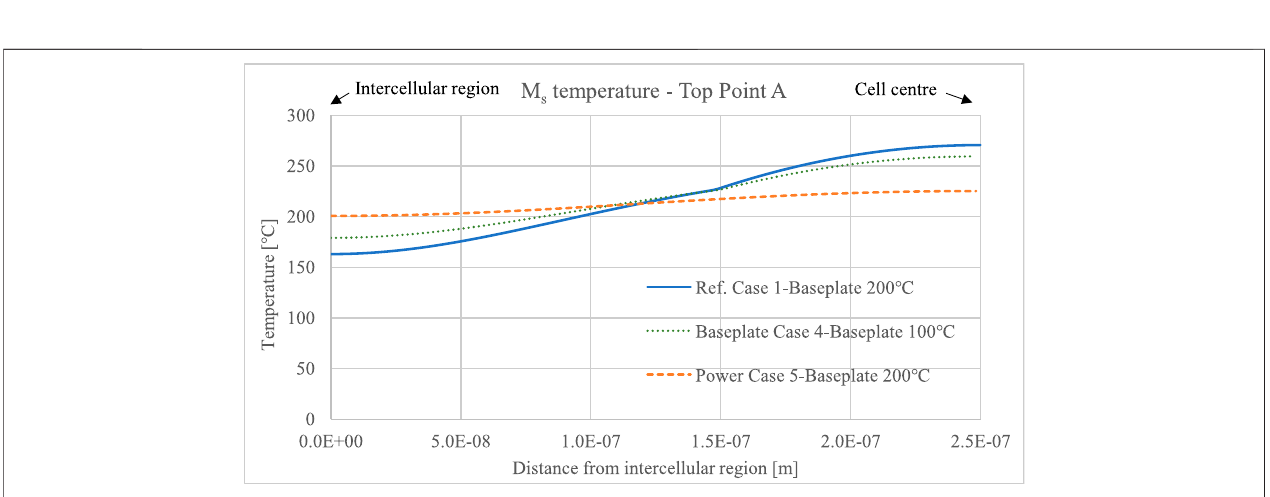
FIGURE 15 | Calculated M s temperature variation for point A as a function of distance from the intercellular region for cases 1, 4, and 5.